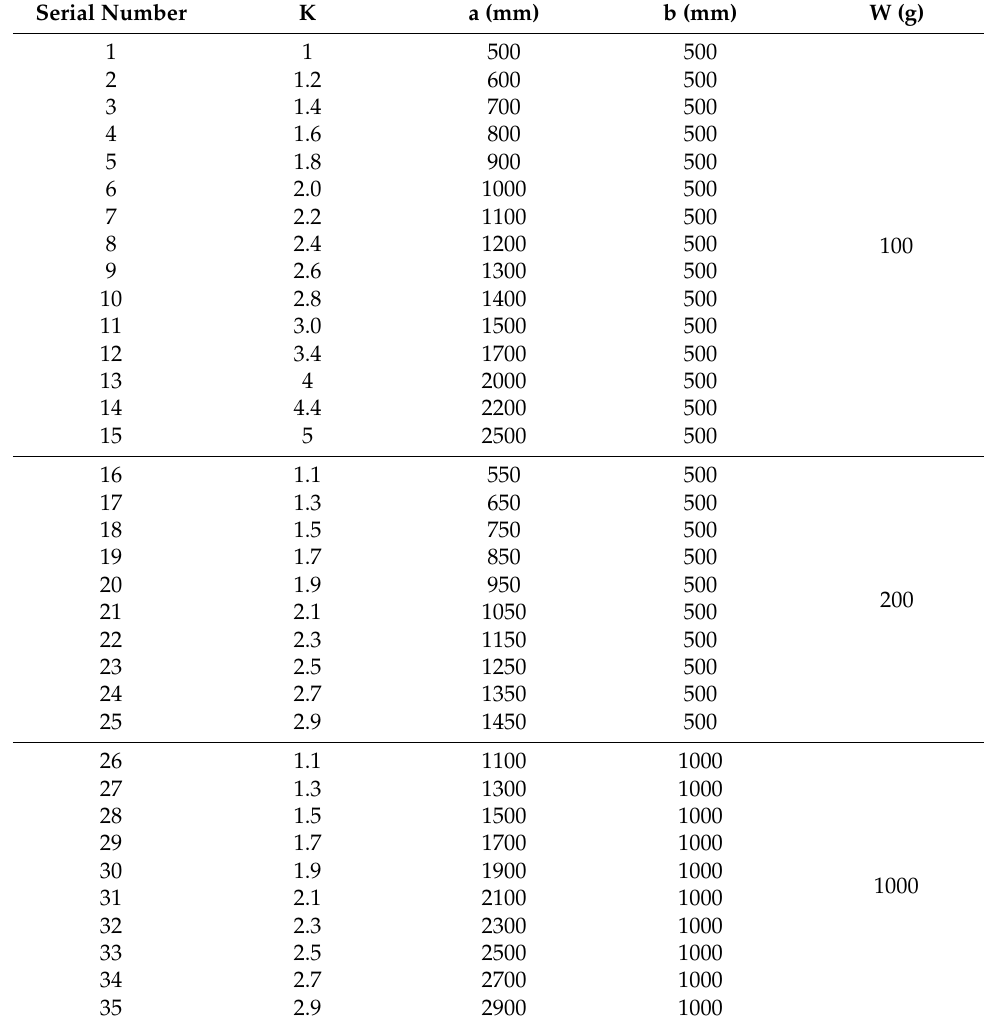
Table 2. Simulation working